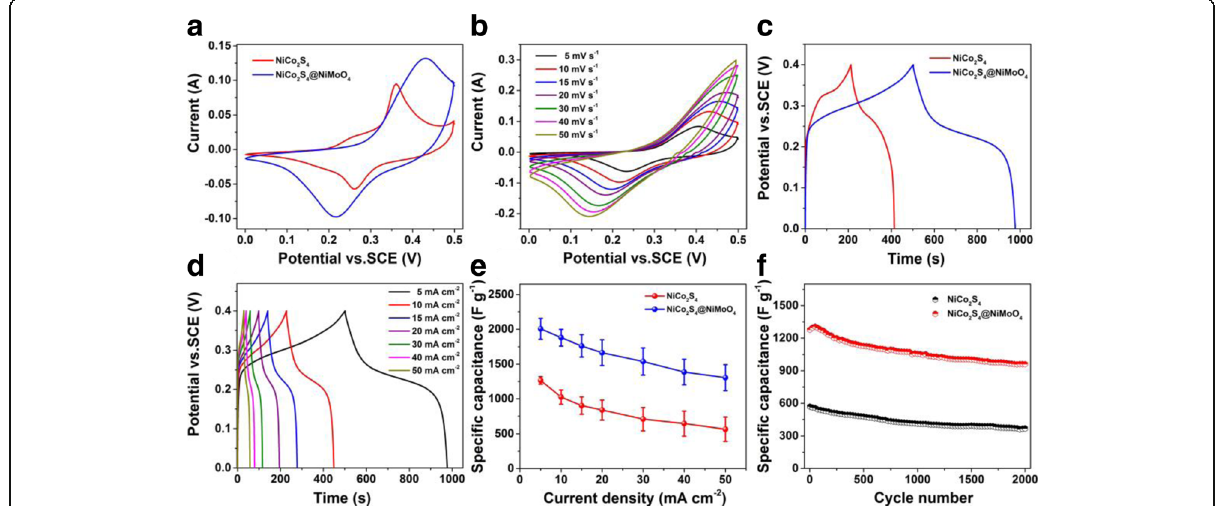
Fig. 4 a The comparison of the CV curves of NiCo 2 S 4 , NiCo 2 S 4 @NiMoO 4 at the scan rate of 10 mV s -2 . b CV curves of the NiCo 2 S 4 @NiMoO 4 product at the scan rates of 5, 10, 15, 20, 30, 40, 50 mV s -1 . c Comparison of GCD curves of the NiCo 2 S 4 , NiCo 2 S 4 @NiMoO 4 at a current density of 5 mA cm -2 . d GCD curves of the NiCo 2 S 4 @NiMoO 4 composite at the current densities of 5, 10, 15, 20, 30, 40, 50 mA cm -2 . e Specific capacitance of the NiCo 2 S 4 , NiCo 2 S 4 @NiMoO 4 composite at different current densities. f Cycling performance of NiCo 2 S 4 , NiCo 2 S 4 @NiMoO 4 composite at 50 mA cm -2 for 2000